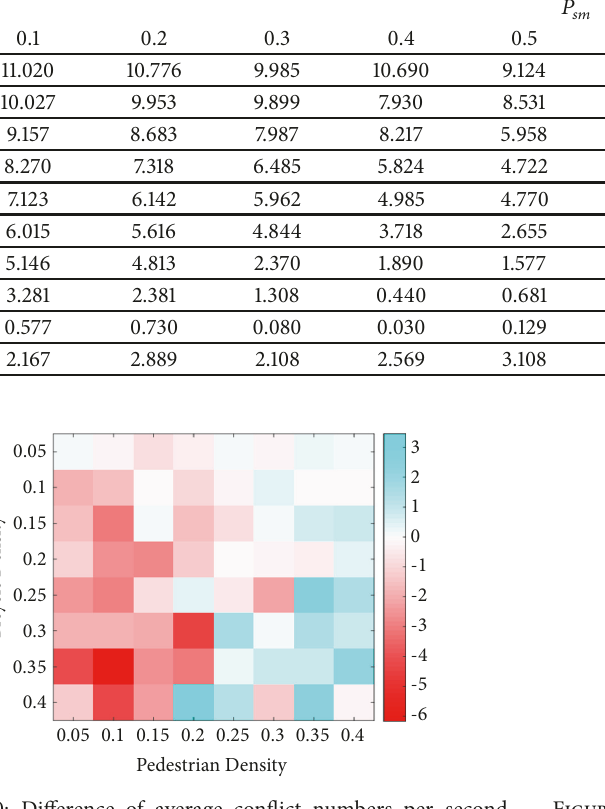
Figure 10: Difference of average conflict numbers per second between the scene with harbor-shaped bus stop and conventional bus stop.